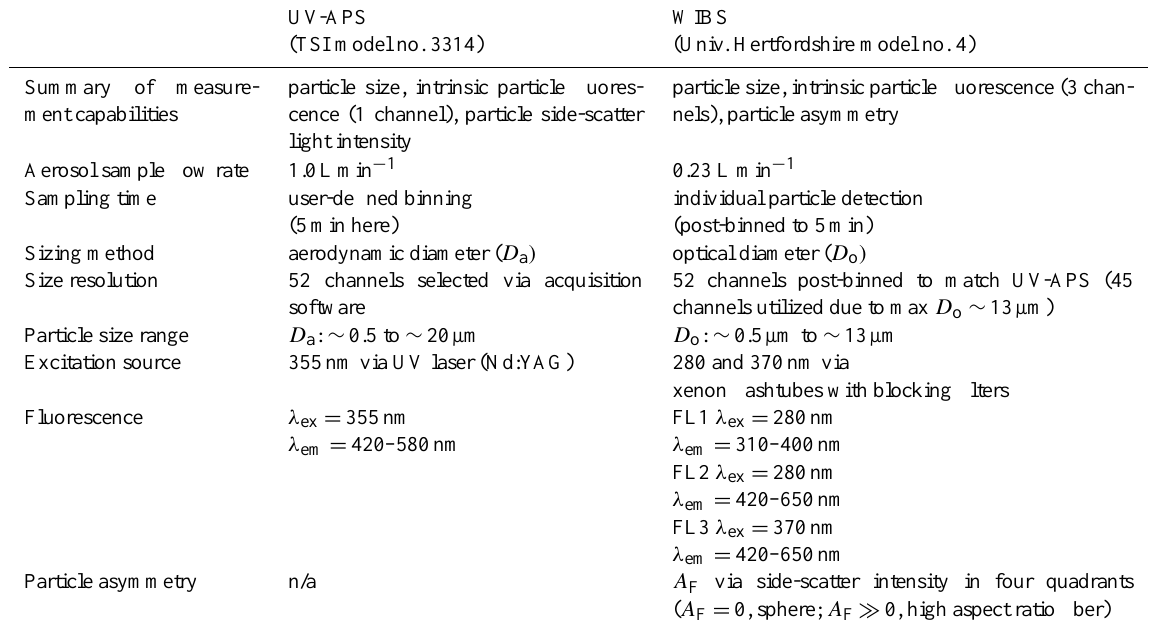
Table 1. A comparison between instrumental parameters used during the study for the UV-APS and WIBS-4 techniques.